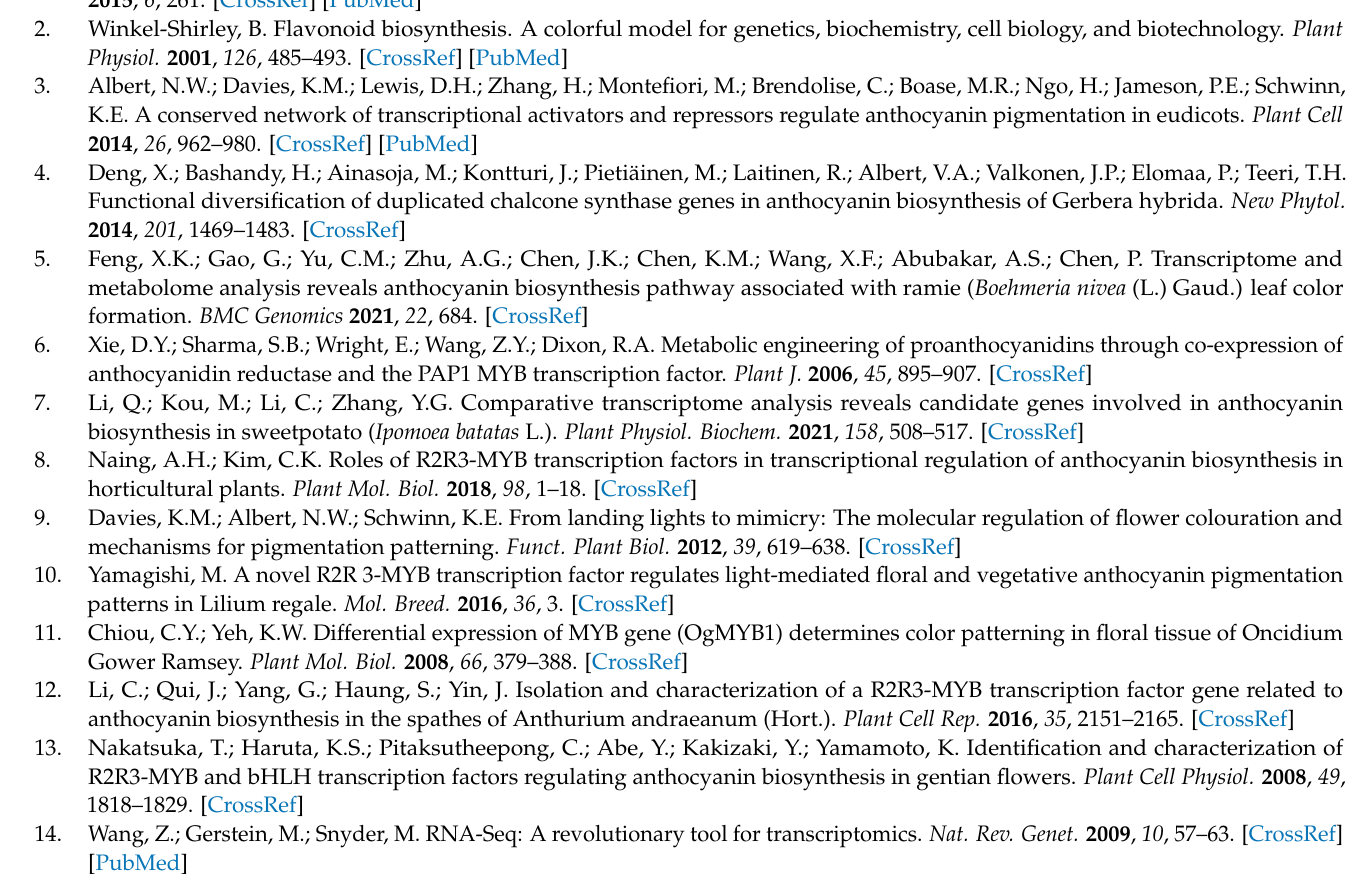
opmental stages, Figure S2: Pearson correlation between samples, Figure S3: Transcription fac- tors in pansy, Figure S4: Phylogenetic tree of VwMYBP and R2R3-MYB in Arabidopsis thaliana , Figure S5: Expression levels of VwMYBP in NBF and BF at six development stages. Table S1: Ba- sic data of transcriptome, Table S2: FPKM distribution of all samples, Table S3: Unigene anno- tation by public databases, Table S4: Information of DEGs, Table S5: GO classification of DEGs, Table S6: KEGG classification of DEGs, Table S7: Unigenes involved in the anthocyanin biosynthesis pathway, Table S8: Primer sequences used for